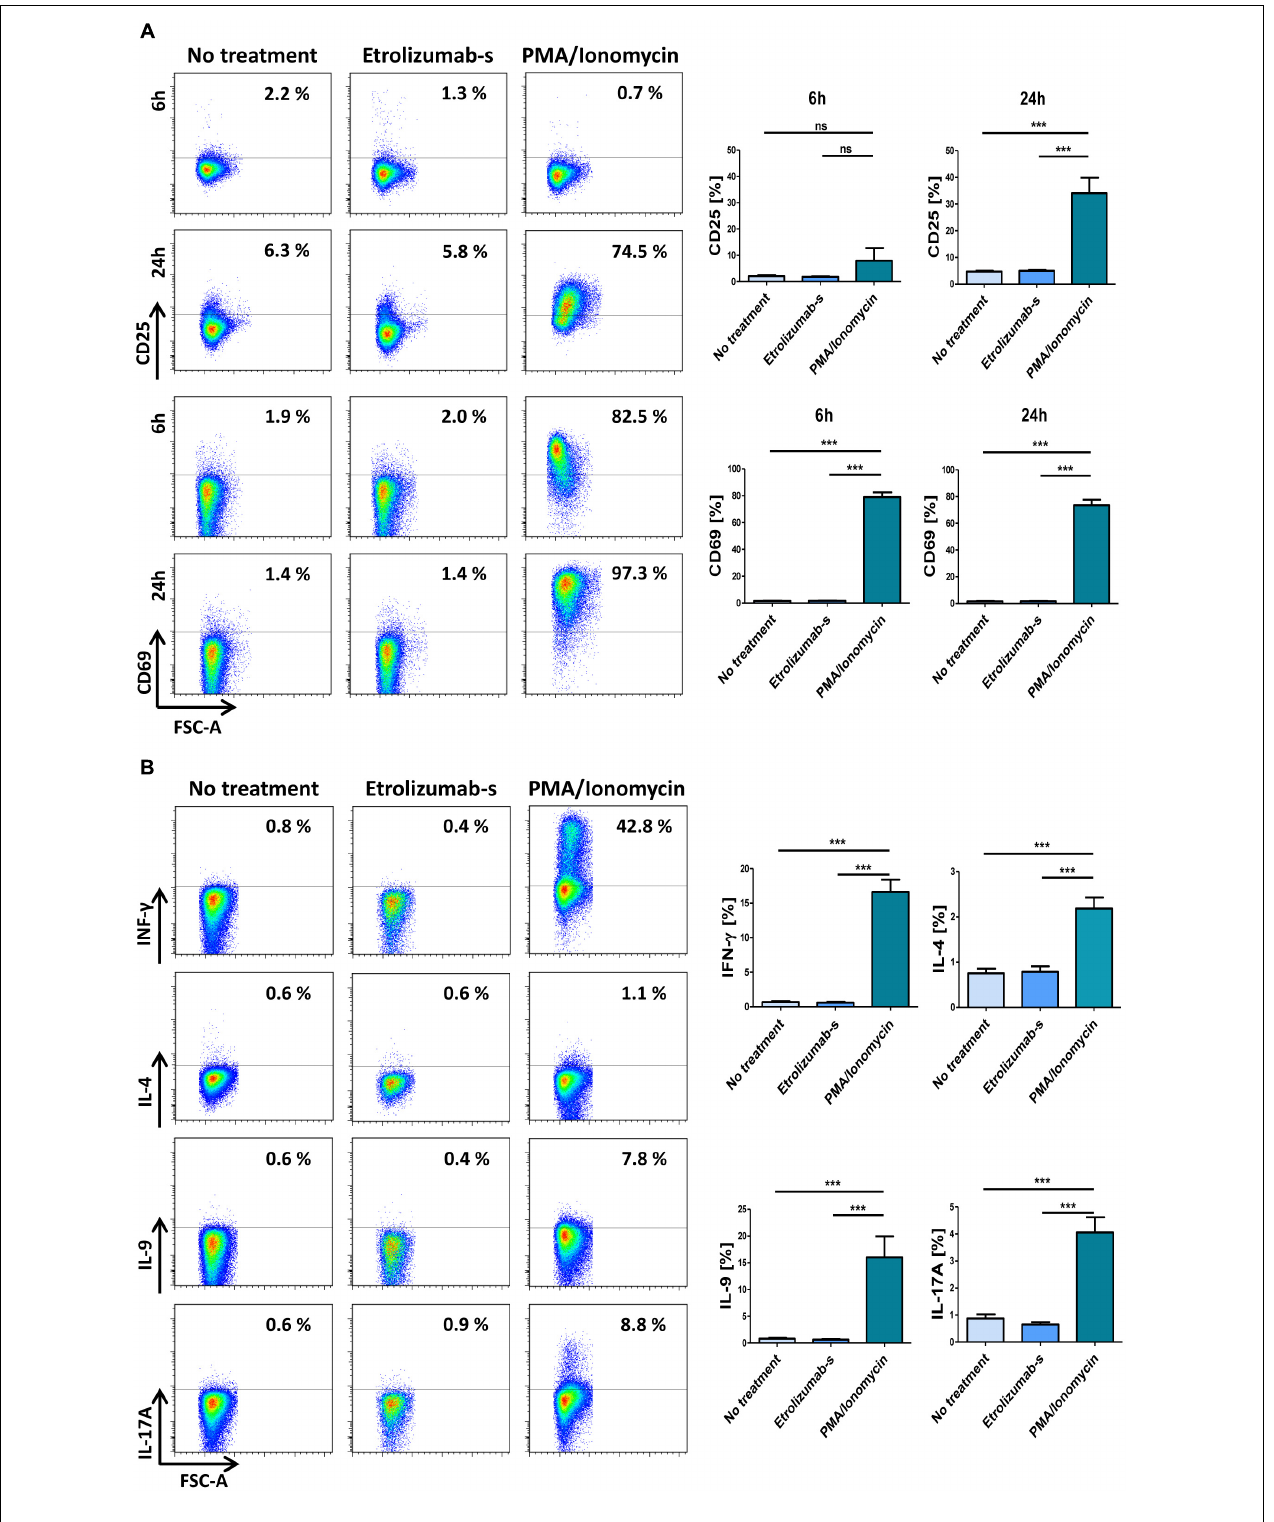
FIGURE 7 | Etrolizumab-s does not elicit agonistic activity and cytokine production. (A) Left panels: Representative flow cytometry showing expression of CD25 (upper panels) and CD69 (lower panels) after cell treatment with or without PMA/ionomycin and etrolizumab-s for 6 or 24 h. Right panels: Quantitative flow cytometry ( n = 11–26). (B) Left panels: Representative flow cytometry showing expression of pro-inflammatory cytokines after cell treatment with or without PMA/ionomycin and etrolizumab-s for 6 h. Right panels: Quantitative flow cytometry ( n = 21–23 per group). ∗∗∗ p < 0.001; ns – not significant.